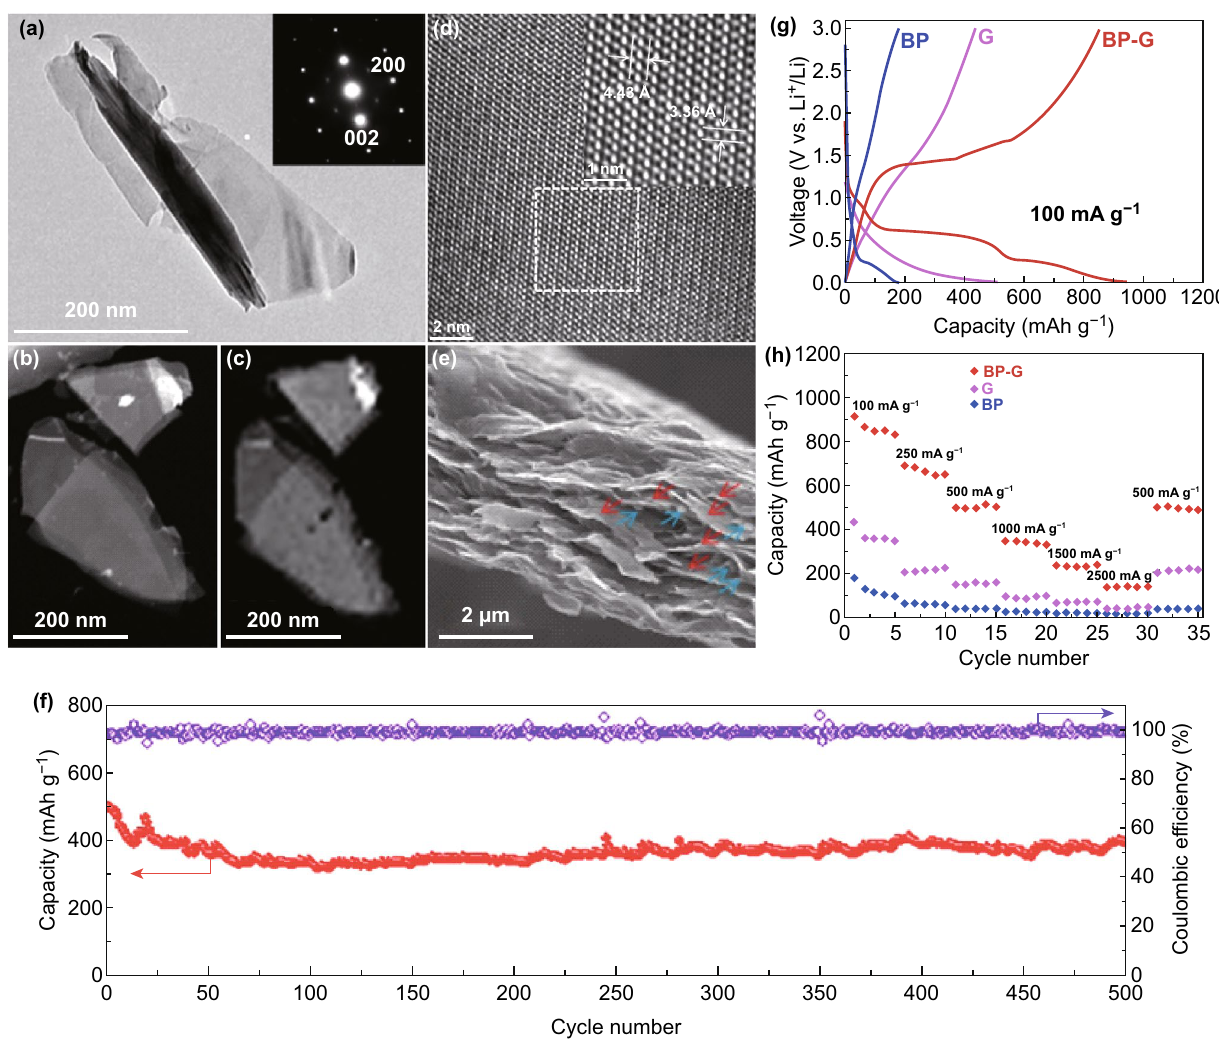
Fig. 8 a TEM image of BP nanosheets with the zone axis along [010] in electron diffraction pattern. b STEM-HAADF image of two thin-layer black phosphorus. c EDS mapping of elements d HRTEM images of thin-layer black phosphorus e SEM images of 2D BP/graphene composite materials cross-sectional view. f Second galvanic charge/discharge performance of thin-layer BP, graphene and 2D BP/graphene hybrid sheets at a current density of 100 mA g −1 . g Rate performance of thin-layer black phosphorus, graphene and 2D BP/graphene hybrid sheets at differ- ent current densities. h Cycling performance and coulombic efficiency of 2D BP/graphene composite anode materials under a current density of 500 mA g −1 after 500 cycles. Adapted with permission [137]. Copyright 2016 John Wiley and